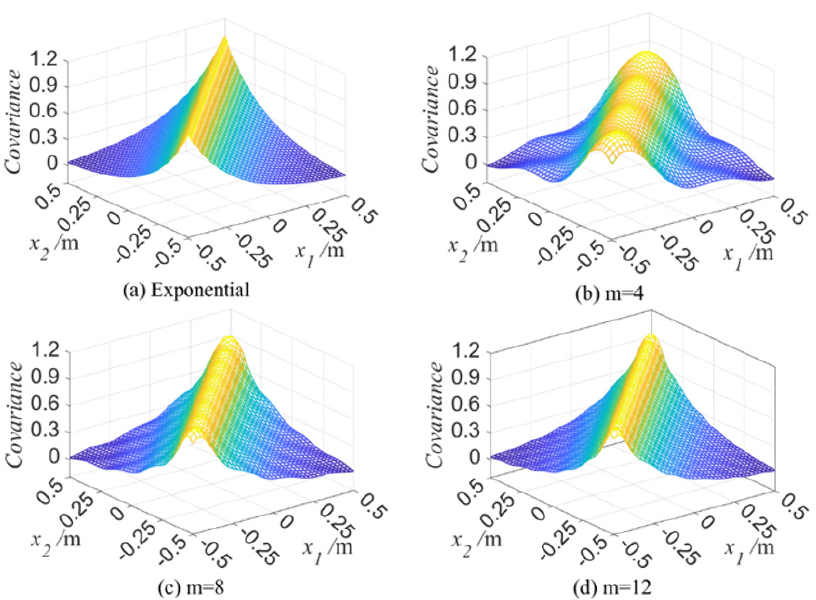
( ) , C x x of 1D random variable when 4,8,12 = m , 1 2